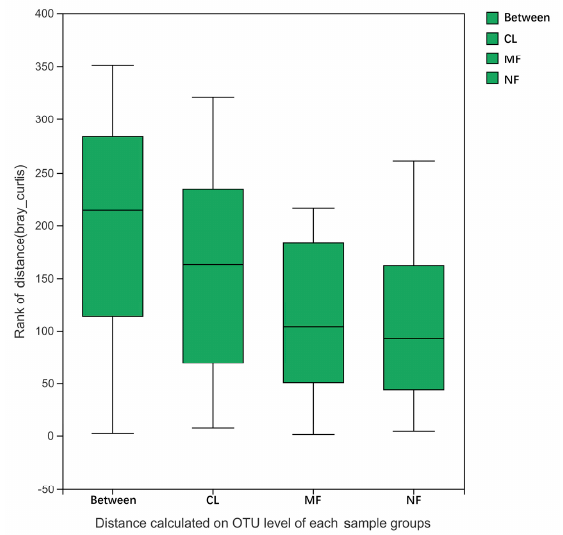
Figure 1. OTU Venn analysis of the soil bacterial communities in the three land-use types. NF—natural secondary forest; MF—managed forest; CL—cropland.